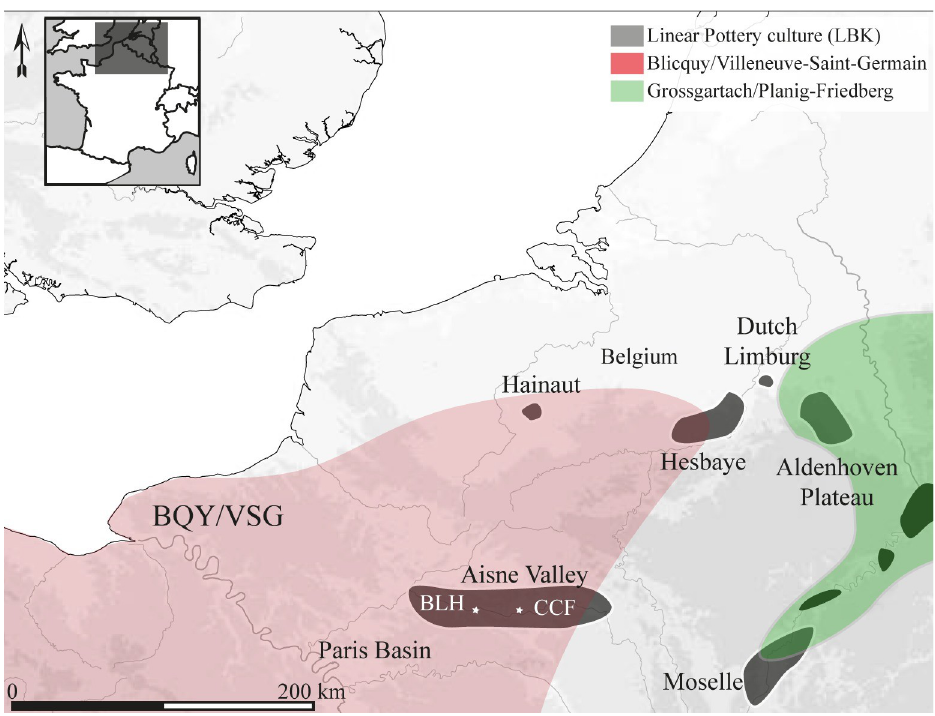
Fig 1. Map of the Early Neolithic in the Rhine, Meuse and Paris basins. The two steps of the Early Neolithic are represented by the Linear Pottery Culture (LPC or LBK) and the second stage by the Blicquy / Villeneuve-Saint- Germain culture (BVSG) in the Paris Basin and Belgium and in western Germany, the Hinkelstein and Grossgartach cultures, followed by the Planig-Friedberg. Bacground map: Digital elevation model BD ALTI 1 from the IGN, 16 of february